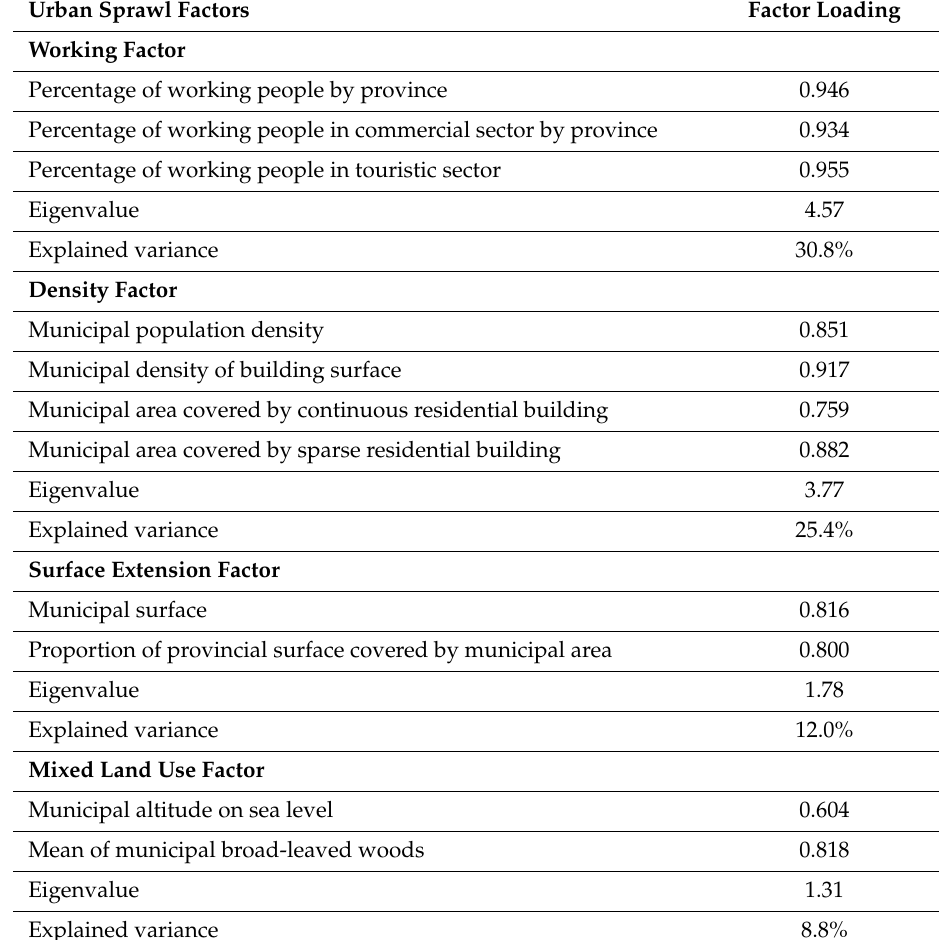
Table 1. Variables loading of sprawl / compactness index for Sicilian municipalities.